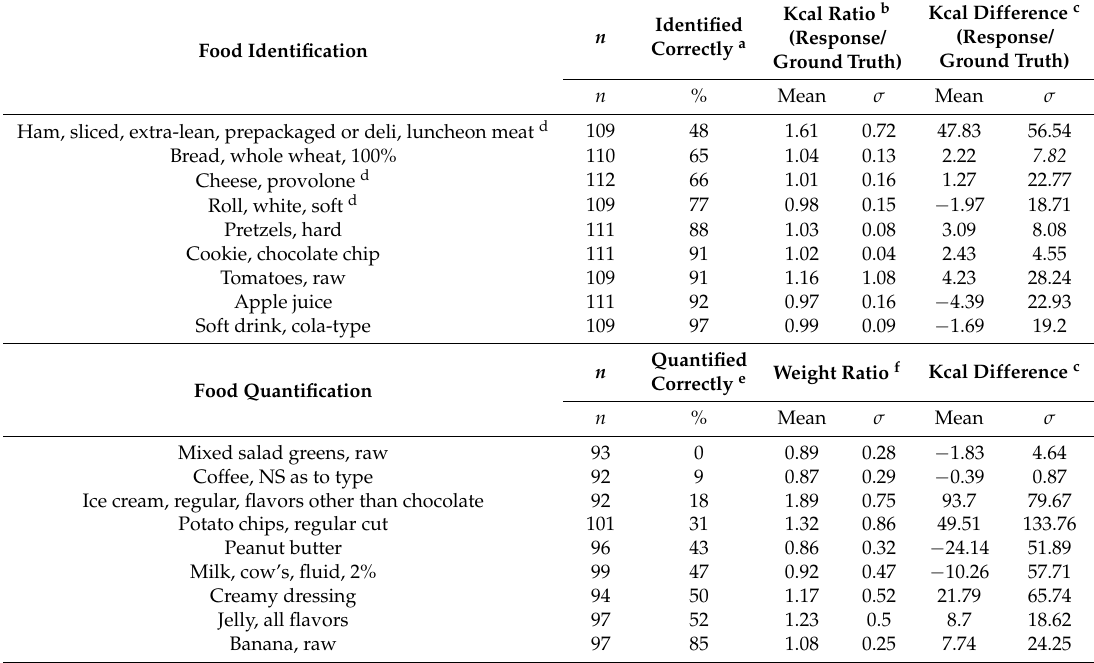
Table 2. Participants ( n = 114) ability to accurately identify and quantify selected foods from images in the Diet Assessment